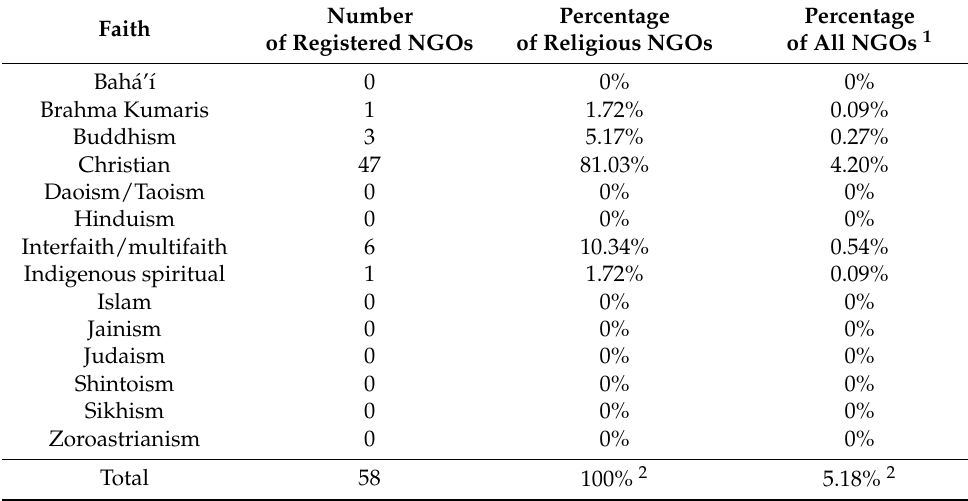
Table 2. Religious NGOs at COP